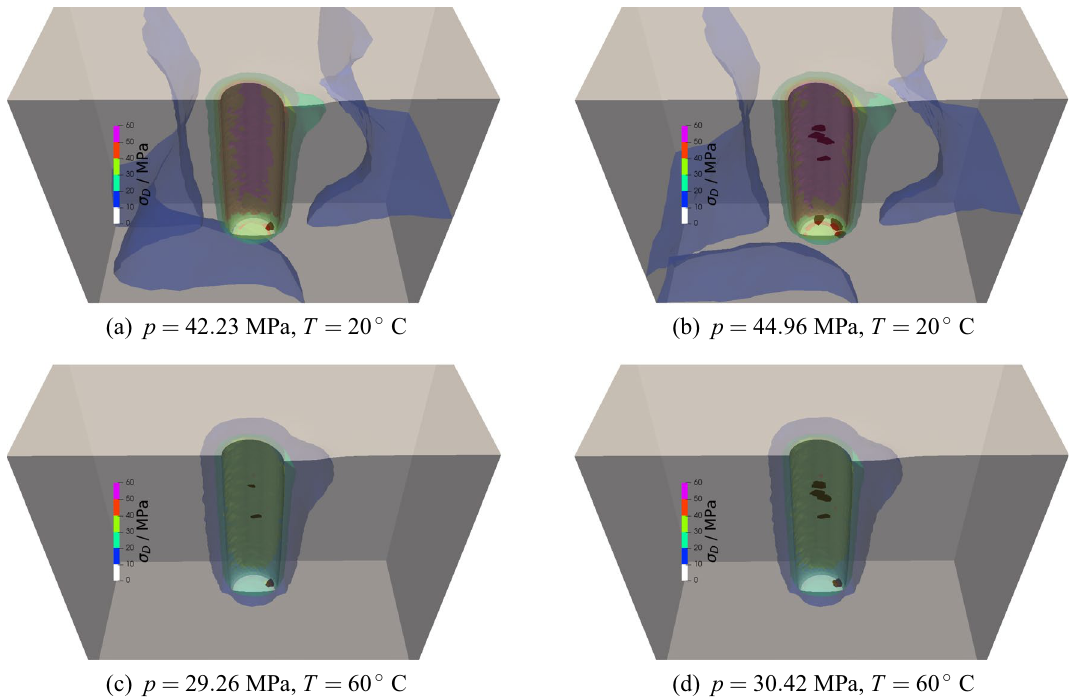
Figure 3. The numerical simulations of the stress concentration effects in procedure P1 (see Methods). The red 10 − 4 ) and the contour map the deviatoric stress σ D distribution at the mixed- spots indicate damaged areas ( d ≥ mode initiation pressure ( a , c ) and mode-I propagation pressure ( b , d